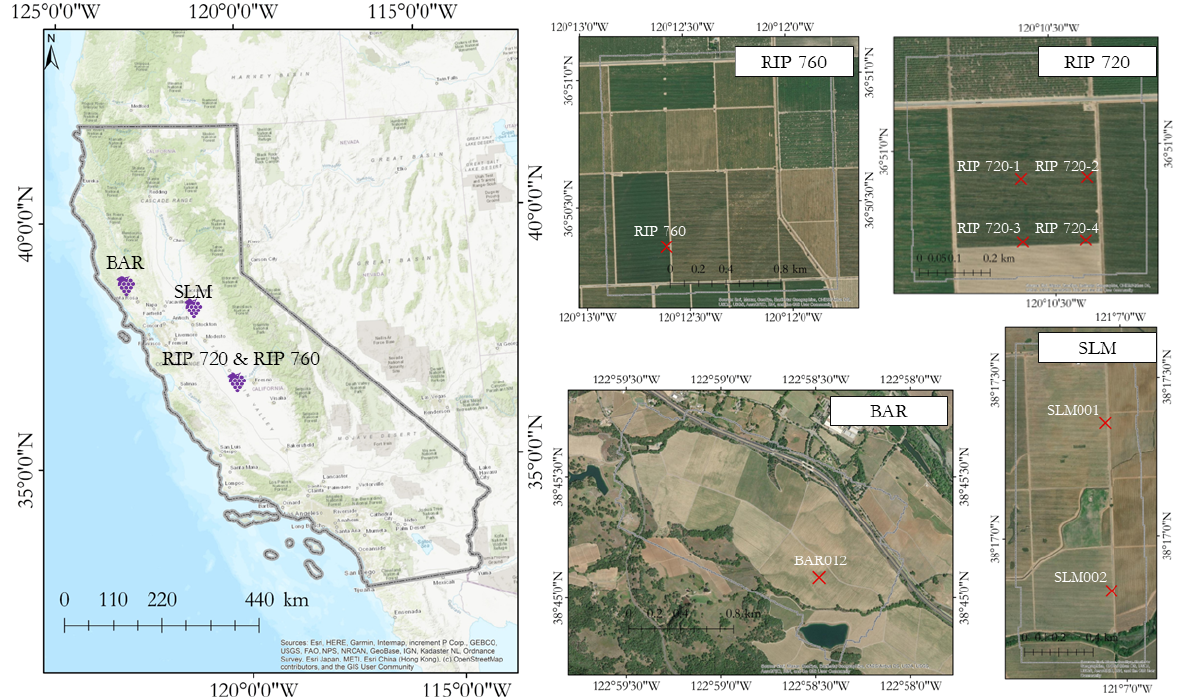
Figure 1. Study areas in California and the position of EC flux towers at each research site. The position of each EC flux tower within the respective research sites is marked by a red cross and the corresponding tower name in white font.